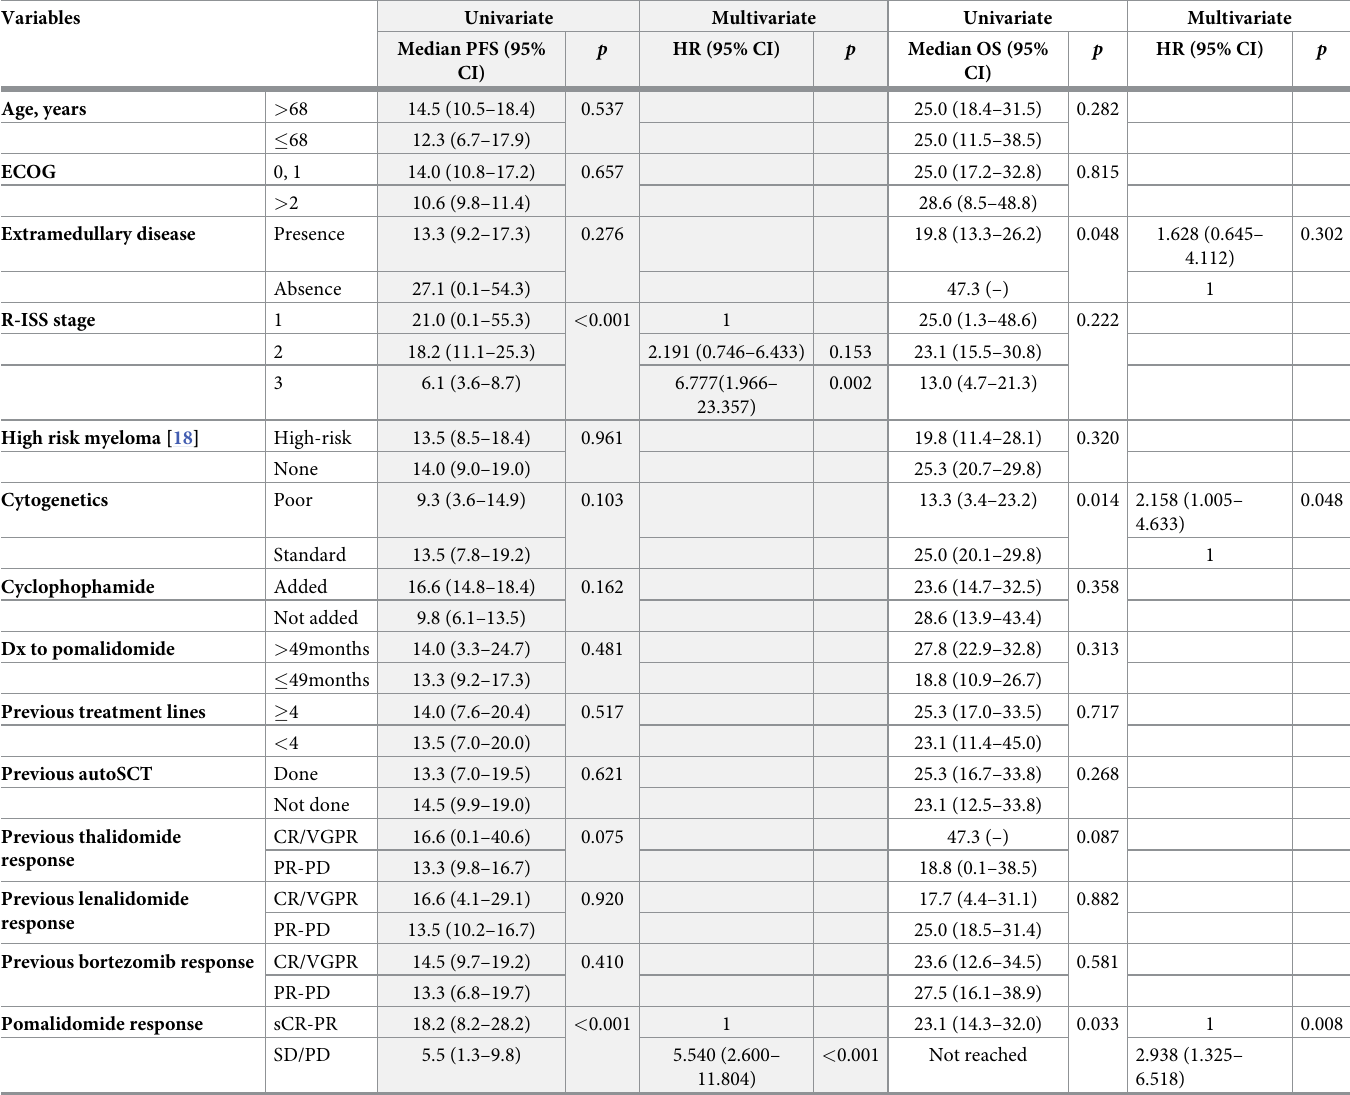
Table 3. Progression free survival and overall survival in all